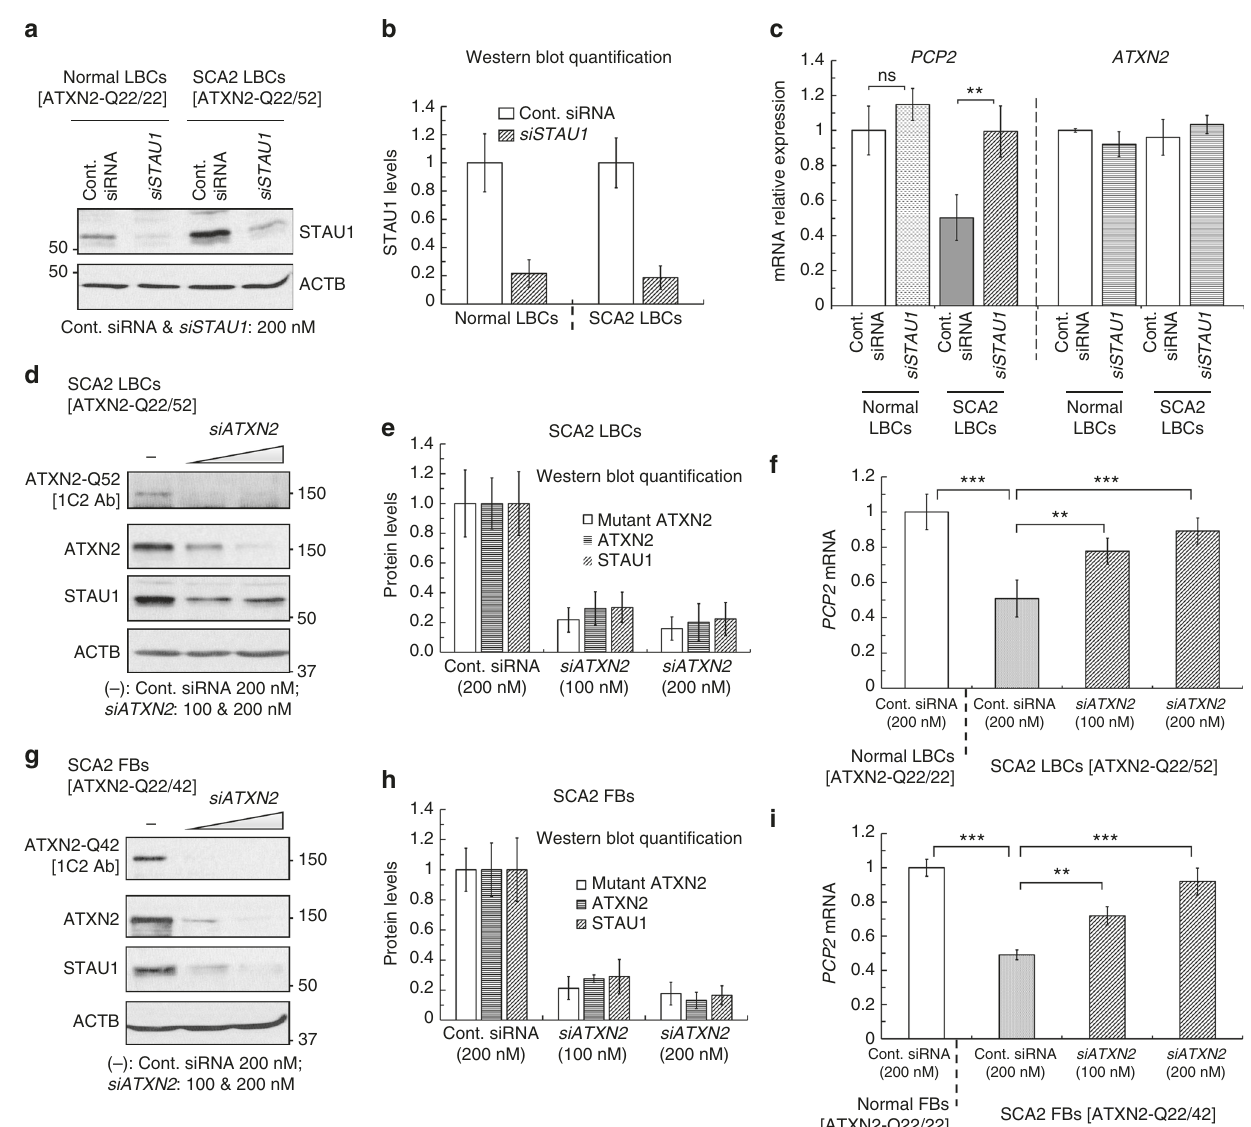
Fig. 6 Lowering STAU1 restores PCP2 expression in SCA2 cells. a Normal [ATXN2-Q22/22] and SCA2 [ATXN2-Q22/52] LBCs were electroporated with STAU1 siRNA and STAU1 levels were determined by western blotting 4 days post-electroporation. b Quanti fi cation of three independent experiments of the blot in a . c Matched cultures were used for qRT-PCR analyses to measure PCP2 transcript levels. STAU1 depletion is associated with increased PCP2 transcript levels in SCA2 LBCs. PCP2 mRNA is unchanged upon STAU1 knockdown in normal LBCs. STAU1 silencing does not alter ATXN2 transcript steady-state levels in normal or SCA2 LBCs. d – i ATXN2 siRNA lowers STAU1 levels and increases PCP2 expression in SCA2 cells. d SCA2 LBCs [ATXN2- Q22/52] were electroporated with siATXN2 and evaluated by western blotting. e Quanti fi cation of three independent experiments of the blot in d . f Matched cultures were used for qRT-PCR analyses to measure PCP2 transcript levels, demonstrating PCP2 expression increased with siATXN2